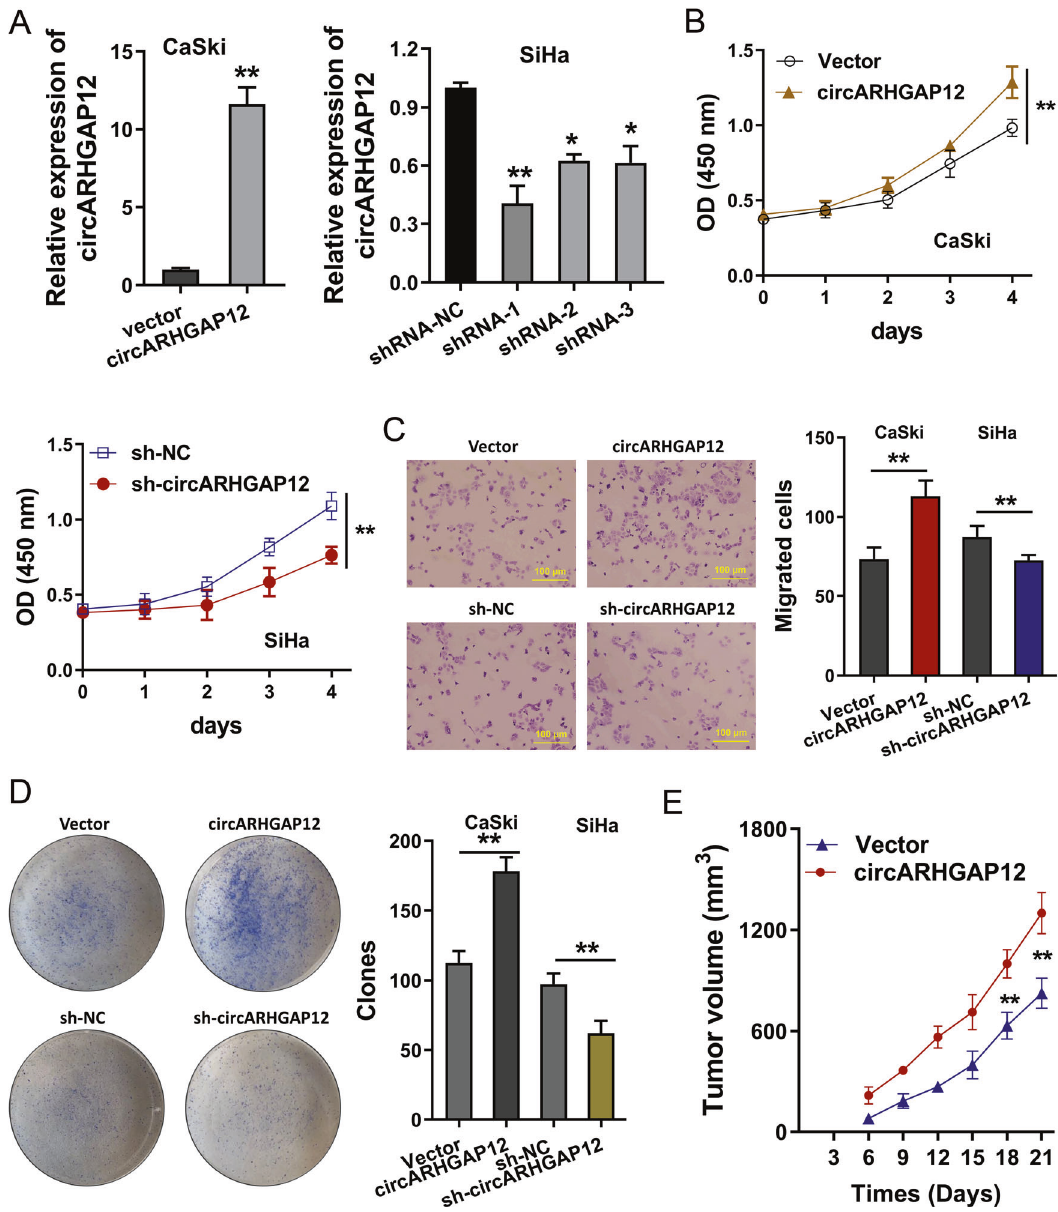
Fig. 3 circARHGAP12 promoted the tumorigenesis of cervical cancer. A Overexpression and knockdown of circARHGAP12 were constructed using stable transfection. Expression of circARHGAP12 was detected using RT-qPCR. B CCK-8 proliferation assay demonstrated the proliferative ability of cervical cancer cells (CaSki and SiHa) respectively transfected with circARHGAP12 knockdown (sh-circARHGAP12) and circARHGAP12 overexpression (circARHGAP12). C Transwell migration assay illustrated the migration of cervical cancer cells (CaSki and SiHa) transfected with circARHGAP12 knockdown (sh-circARHGAP12) and circARHGAP12 overexpression (circARHGAP12). D Colony formation assays displayed the colony formation of cervical cancer cells. E In vivo mice assay found the tumor growth in mice injected of circARHGAP12 overexpression cells (CaSki cells). Experiments were performed in triplicate. P values were calculated by Student ’ s t -test. ** p <